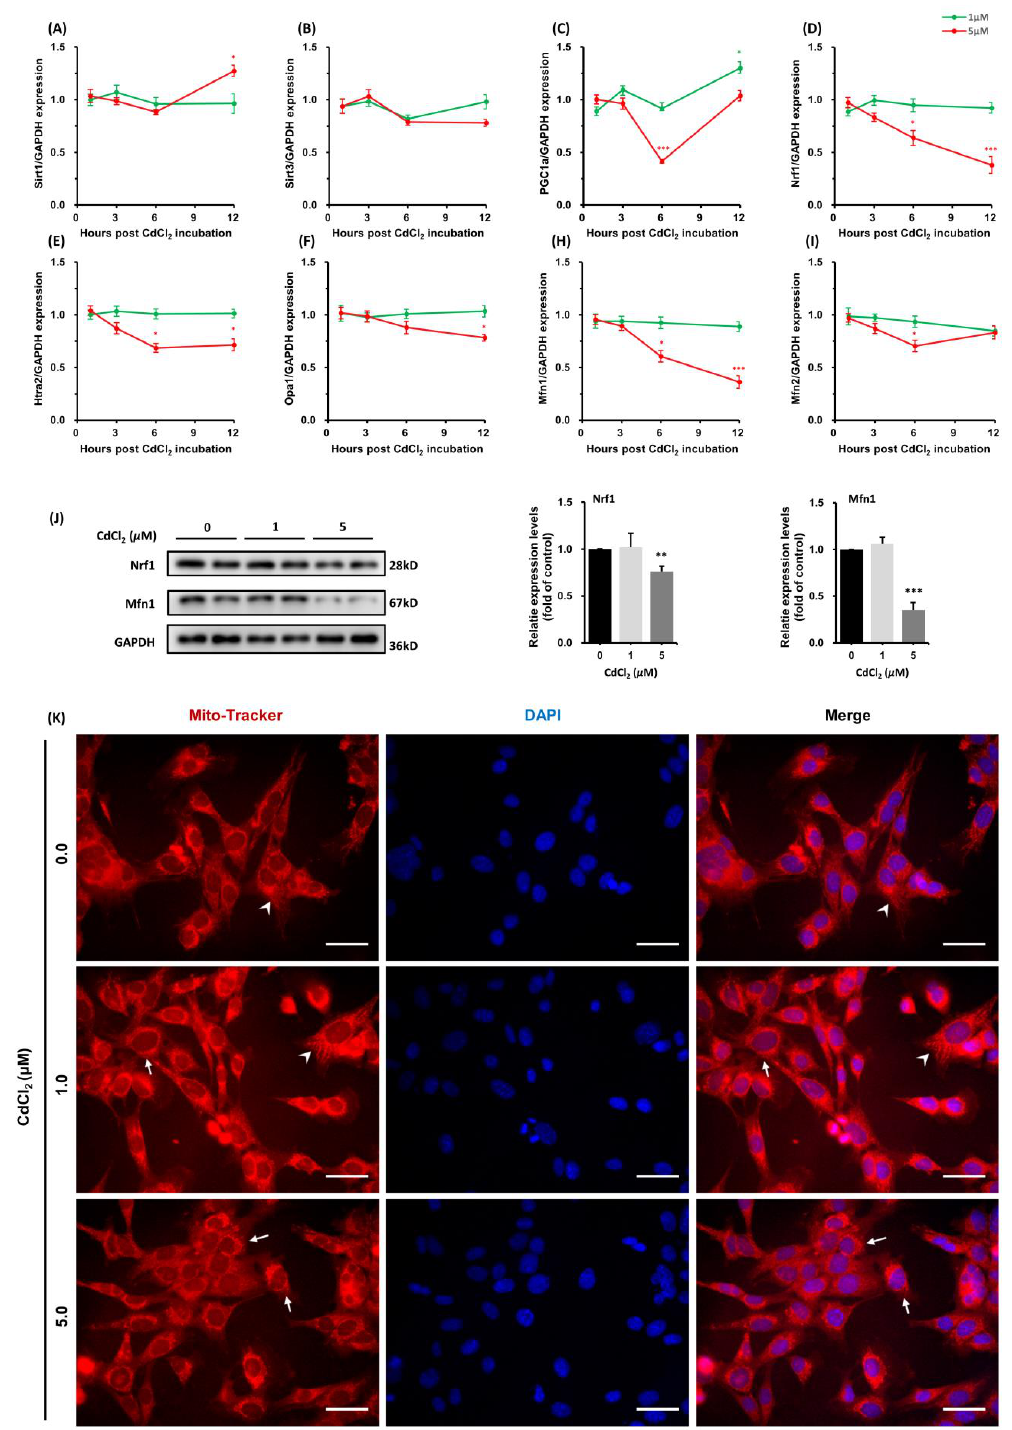
Figure 3. CdCl 2 disturbed mitochondrial homeostasis in the Sertoli cell line. The mRNA levels of genes related to UPRmt ( A – E ) and mitochondrial dynamics ( F – H ) were measured by using qPCR at 1, 3, 6, and 12 h after treatment with CdCl 2 (1, 5 µ M). The protein levels of Nrf1 and Mfn1 at 12h were evaluated by immunoblotting ( I ). Note that CdCl 2 treatment induced an alternation in mitochondria morphology as show with Mito-Tracker staining ( J ). The tubular mitochondria is marked with an arrowhead, and the dotted mitochondria is marked with an arrow. Scale bar 50 µ m for immunofluorescence images. * p < 0.05 compared to the control group, ** p < 0.01 compared to the control group, and *** p < 0.001 compared to the control